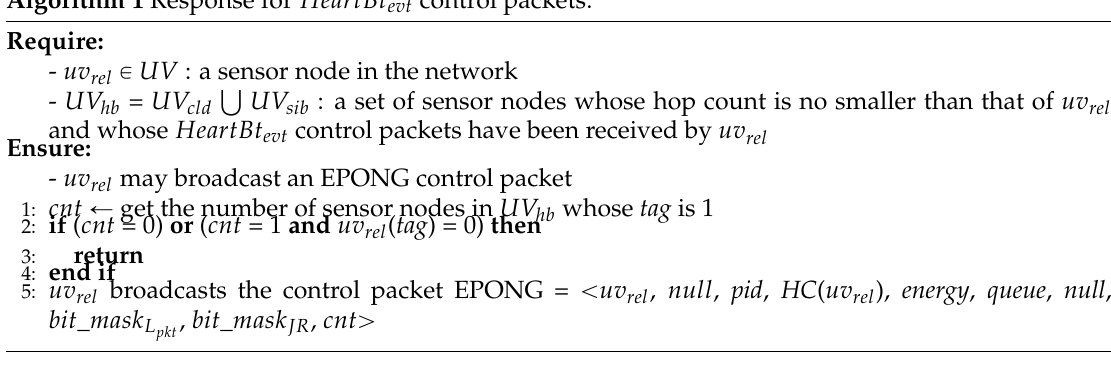
Algorithm 1 Response for HeartBt evt control